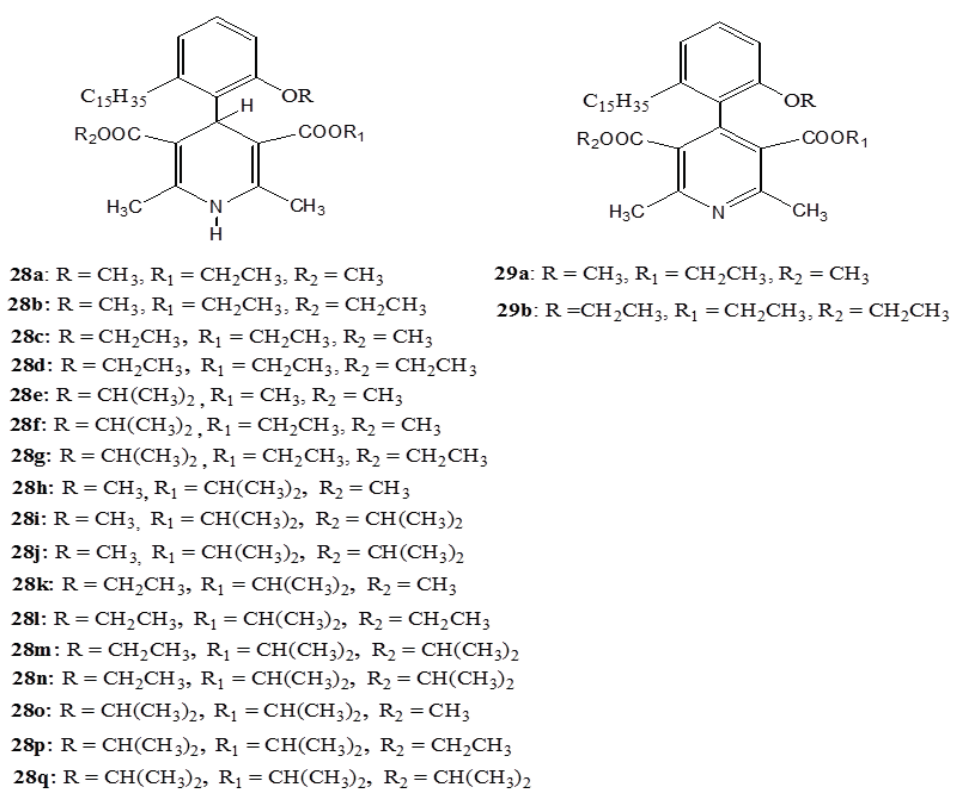
Figure 11. The dihydropyridine derivatives 28 and 29